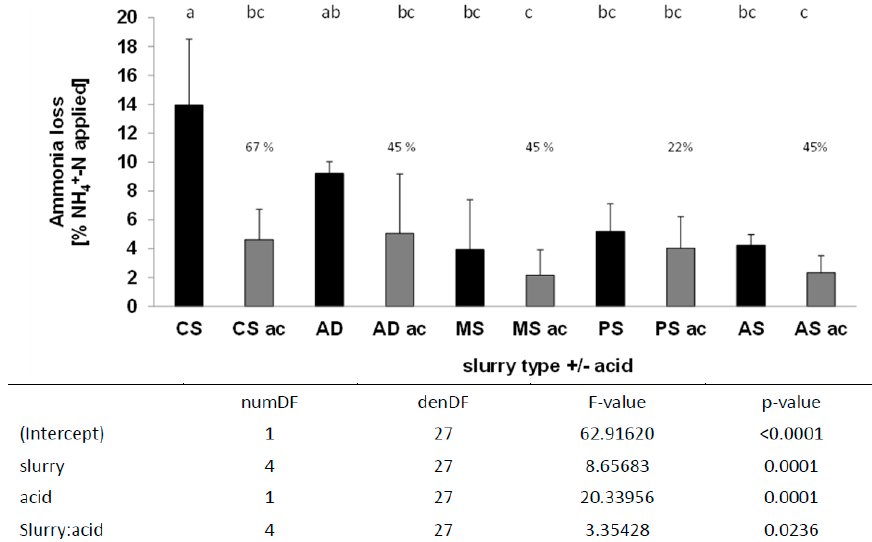
Figure 3. NH 3 loss after application of five different slurries with and without acidification by trail hoses, first winter wheat trial. Applied NH4+ ‐ N kg ha − 1 : CS = 84.8, AD = 79.5, MS = 78.75, PS = 84.42, and AS = 79.5, n = 4; mixed effects model, HSD test p < 0.05, n = 4; lowercase letters indicate signifi ‐ cant differences between treatments; CS, cattle slurry; A, anaerobic digestate; MS, mink slurry; PS, pig slurry; AS, liquid phase separated A; ac, acidification.